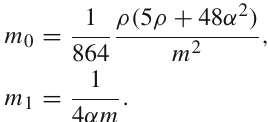
a function in terms of ρ which covers the interval [ 0 , 2 m ]